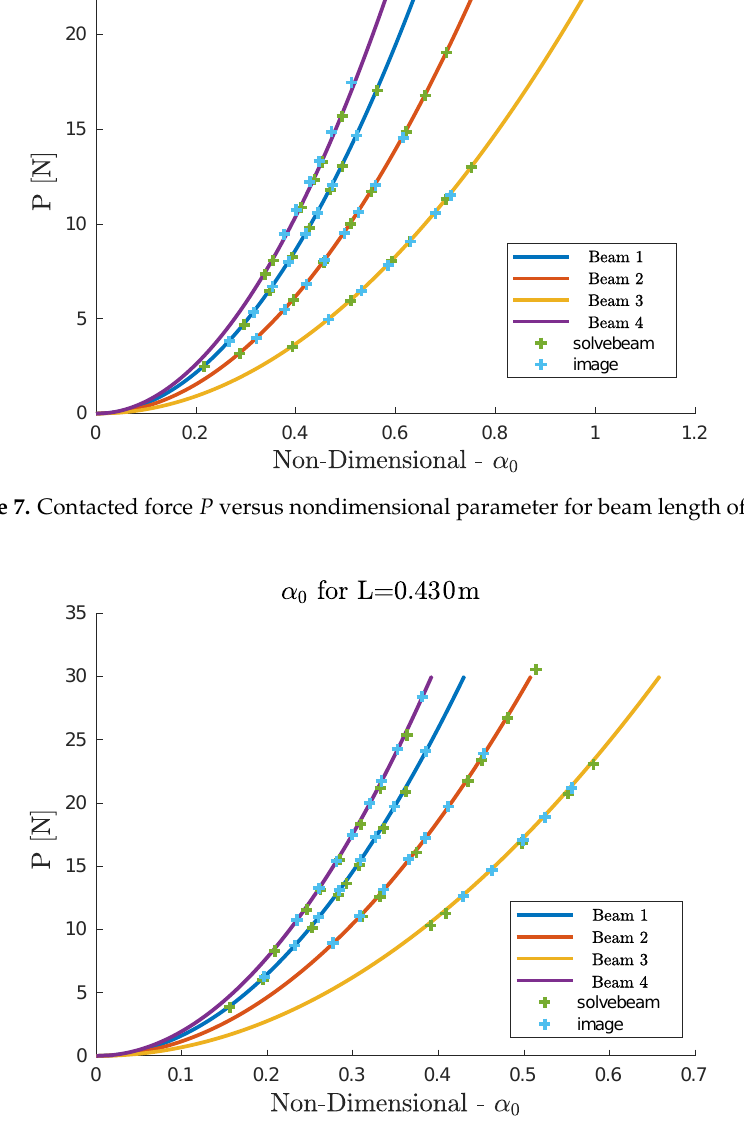
Figure 8. Contacted force P versus nondimensional parameter for beam length of 0.43